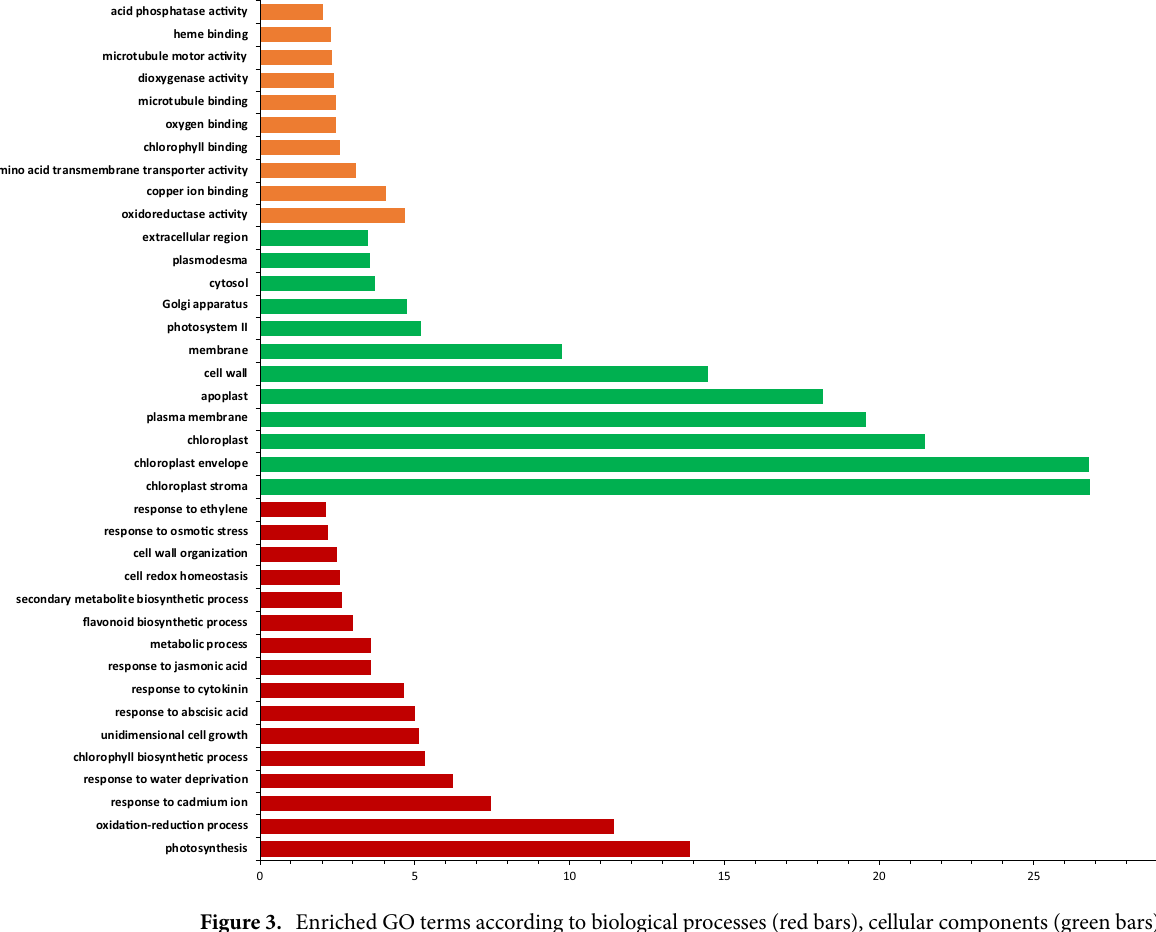
Figure 3. Enriched GO terms according to biological processes (red bars), cellular components (green bars) and molecular functions (orange bars). The x -axis represents log2 of the gene